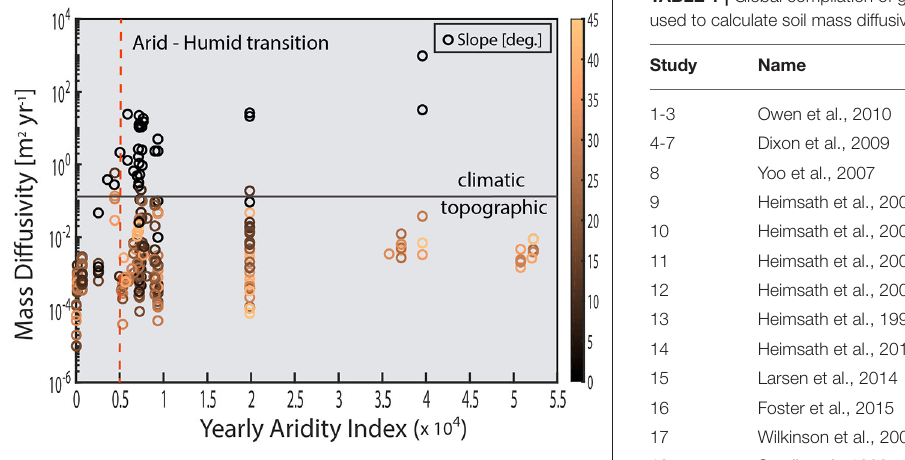
FIGURE 4 | Global compilation of soil mass diffusivity values plotted against the CGIAR yearly average aridity index for each site appear to display differential sensitivity to climate and slope. This figure demonstrates that topographic parameters such as slope or curvature only explain a fraction of the mechanisms of “diffusion.” Geomorphologists and soil scientists have sought to deconvolve the contributions of biota to climatic sensitivity observed in diffusion-like soil movement, though with limited success. However, by relating stirring rate to T ∗ , this provides a new tool in separating abiotic vs. biotic drivers of climate sensitivity brought about by soil stirring. See Appendix for details of data compilation and equations for calculating mass diffusivity.